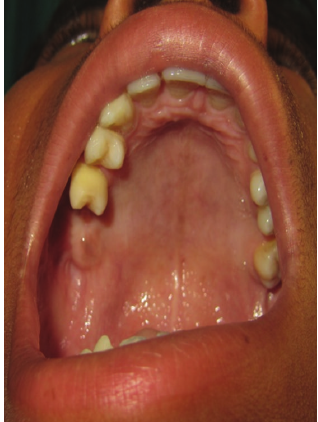
Figure 9: Regression of maxillary lesion.